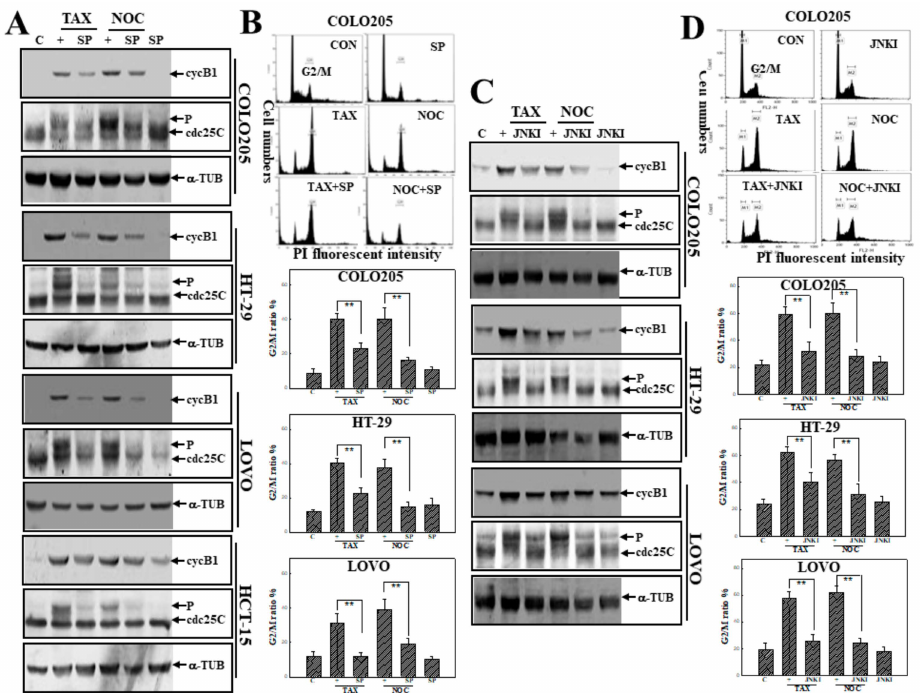
Figure 4. JNK activation is involved in G 2 / M arrest by TAX and NOC in human CRC cells. ( A ) The JNK inhibitor SP inhibited the increase in cyclin B1 and phosphorylated Cdc25C protein expressions by TAX and NOC in human CRC cells. As described in Figure 3A, expressions of cyclin B1, Cdc25C, and α -TUB proteins were examined by Western blotting using specific antibodies. ( B ) SP decreased TAX- and NOC-induced G 2 / M arrest in human CRC cells. As described above, the G 2 / M ratio of indicated cells by TAX and NOC with or without SP (10 µ M) treatment was detected by a flow cytometric analysis using PI staining. ( C ) JNKI inhibited TAX- and NOC-induced phosphorylated Cdc25C and cyclin B1 protein expressions in the indicated human CRC cells. ( D ) As described in ( B ), JNKI reduced the G 2 / M ratio induced by TAX and NOC. Each data point was calculated from three triplicate groups, and data are displayed as the mean ± SD. ** p < 0.01 denotes a significant di ff erence between indicated